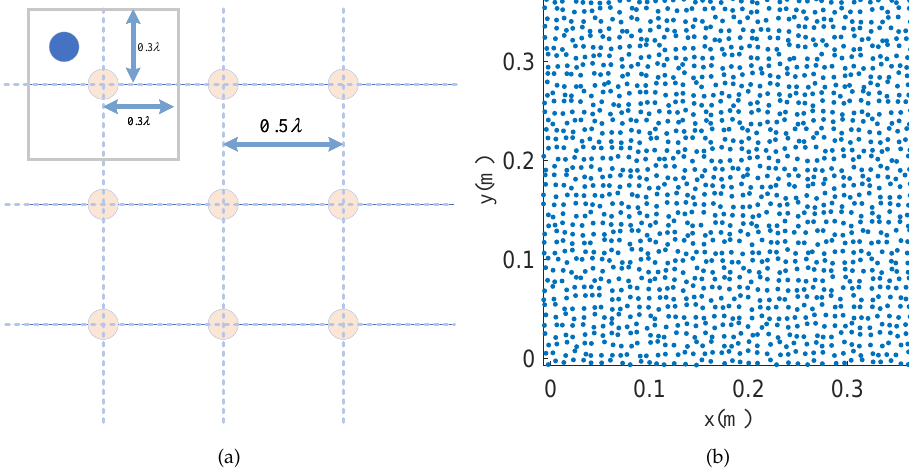
Figure 3. Generation and example of array distribution in the numeric experiments. ( a ) The genera- tion of the random positions of the array. ( b ) A sample distribution of an array of 1600 elements. For the proposed method, we used rectangular sampling and set N s as 44, 46, 48, and 50 to study the effect on performance. γ was set to 17. L was set to 0.1 (we tried a